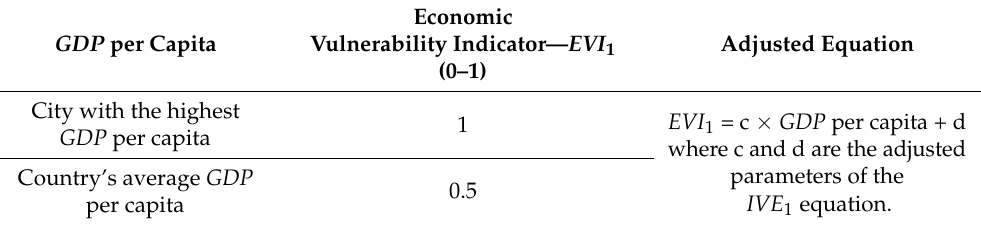
Table 5. Economic vulnerability indicator